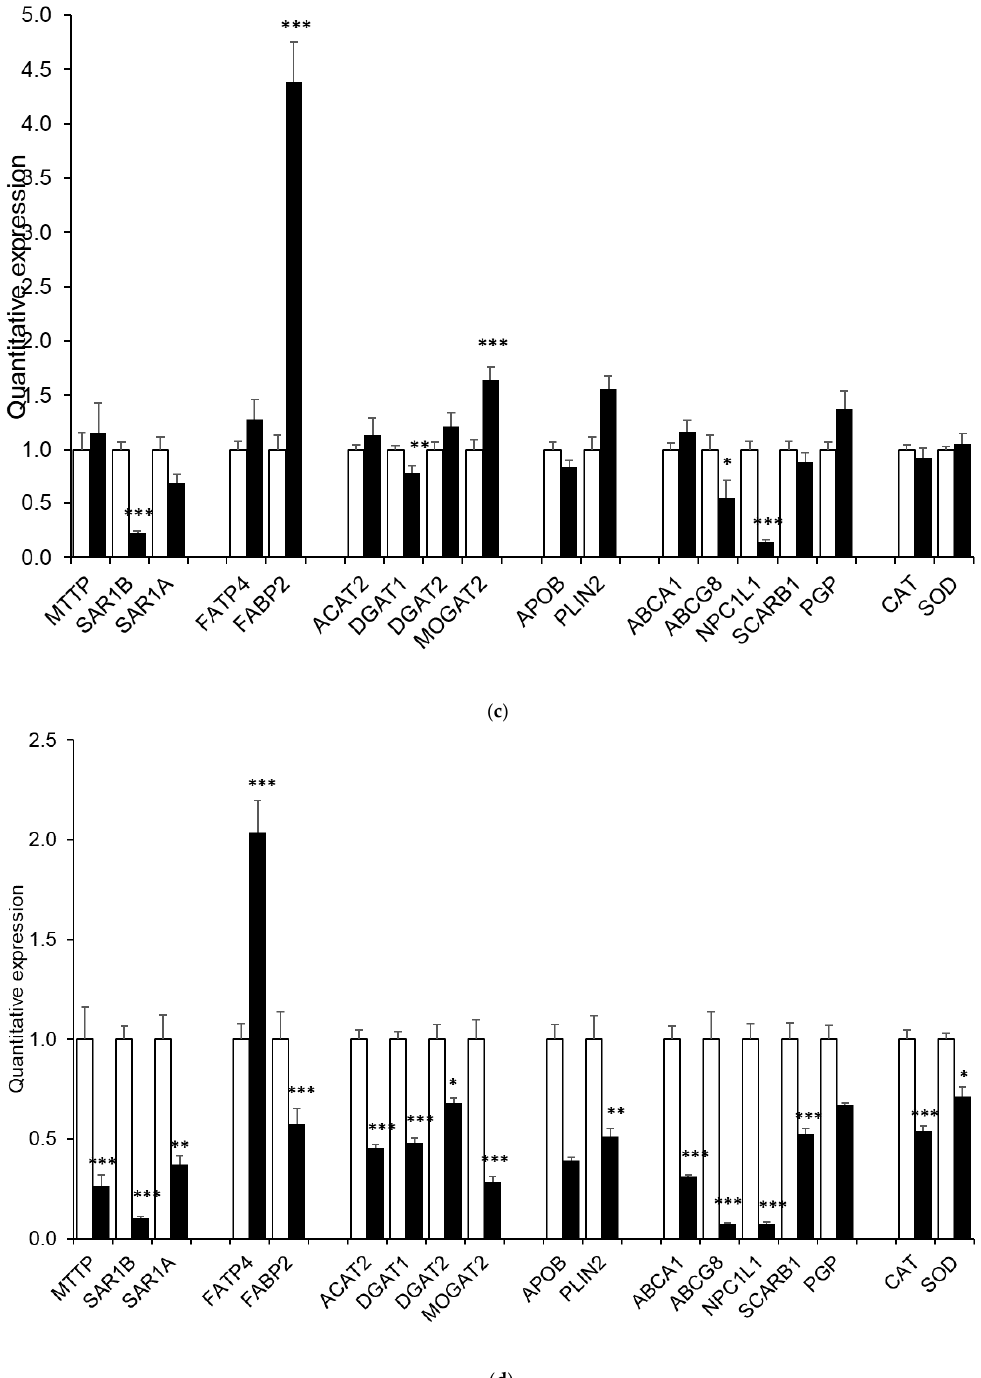
Figure 5. Characterization of clone gene expression. Cells were cultured on inserts for 21 days. We studied genes involved in fatty acid transport ( FATP4 , FABP2 ), intracellular lipid re-synthesis ( ACAT2 , DGAT1 , DGAT2 , MGAT2 ), lipid droplet ( PLIN2 ) or chylomicron ( APOB ) formation, cholesterol metabolism ( ABCA1 , ABCG8 , NPC1L1 , PGP , SCARB1 ) and oxidative stress management ( CAT , SOD1 ) in ( a ) MTTP -KO1, ( b ) MTTP -KO2, ( c ) SAR1B -KO1, ( d ) SAR1B -KO2. Wild-type cells’ mRNA levels were assigned a value of 1, and clones’ mRNA levels were expressed as relative expressions to wild-type cells. Gene expression was measured by RT-qPCR in KO and wild-type Caco-2/TC7 cells. Data are expressed as means ± SEM ( n = 10). Asterisks indicate a statistically significant difference in gene expression levels between control and KO clones (* p < 0.05, ** p < 0.001, *** p < 0.0001). White bars represent control cells; black bars represent considered clones.